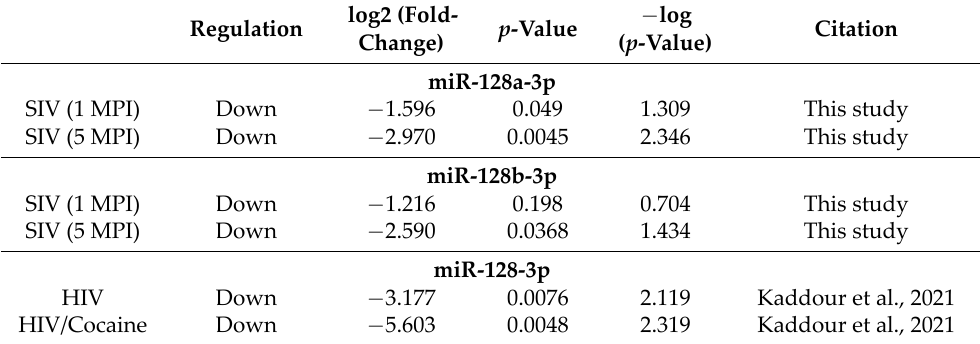
Table 5. Similarities in regulation of EV‑associated miR‑128 by HIV/SIV. − log log2 (Fold‑ Regulation p ‑Value Change) ( p ‑Value)